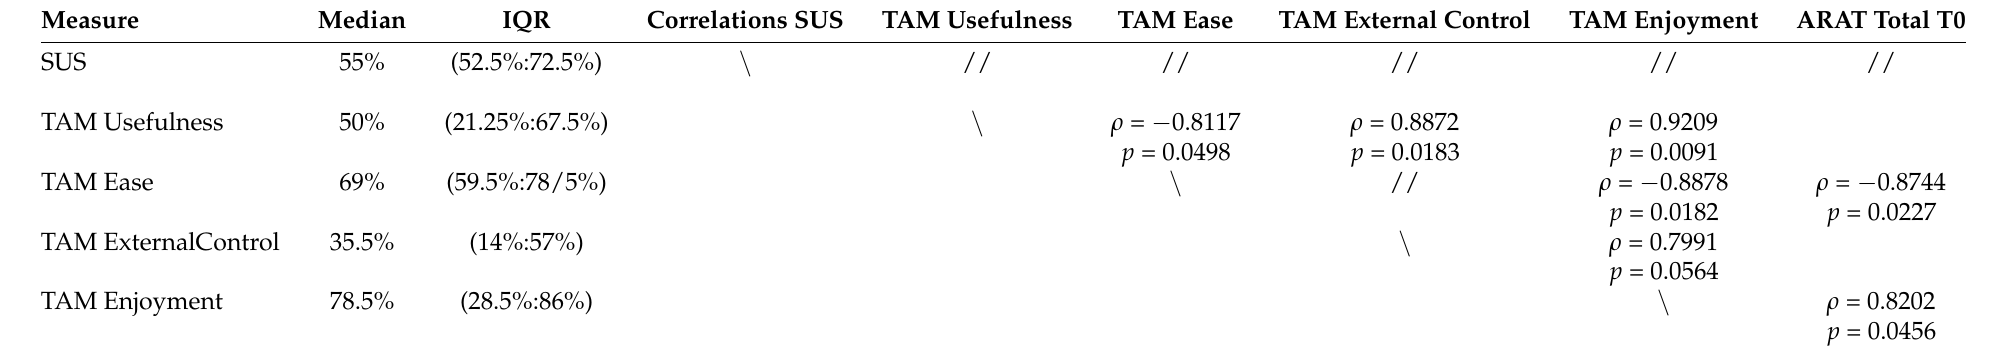
Table 4. Questionnaires analysis. Scores are reported as median and IQR; Spearman correlation between scales is reported for significant and close to significant